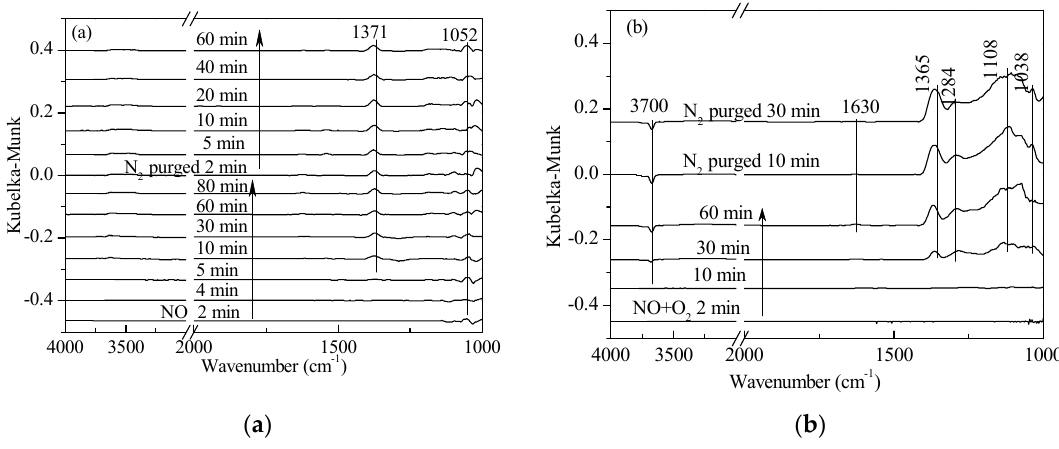
Figure2. In situ DRIFTS spectra of ( a ) NO adsorption and ( b ) NO + O 2 adsorption on 1 wt. % V 2 O 5 -0.2CeO 2 /TiO 2 -ZrO 2 catalysts with N 2 purging for various time at 250 °C after the catalysts were exposed to a flow of 800 ppm NO or 800 ppm NO + 5% O 2 for 60 min.